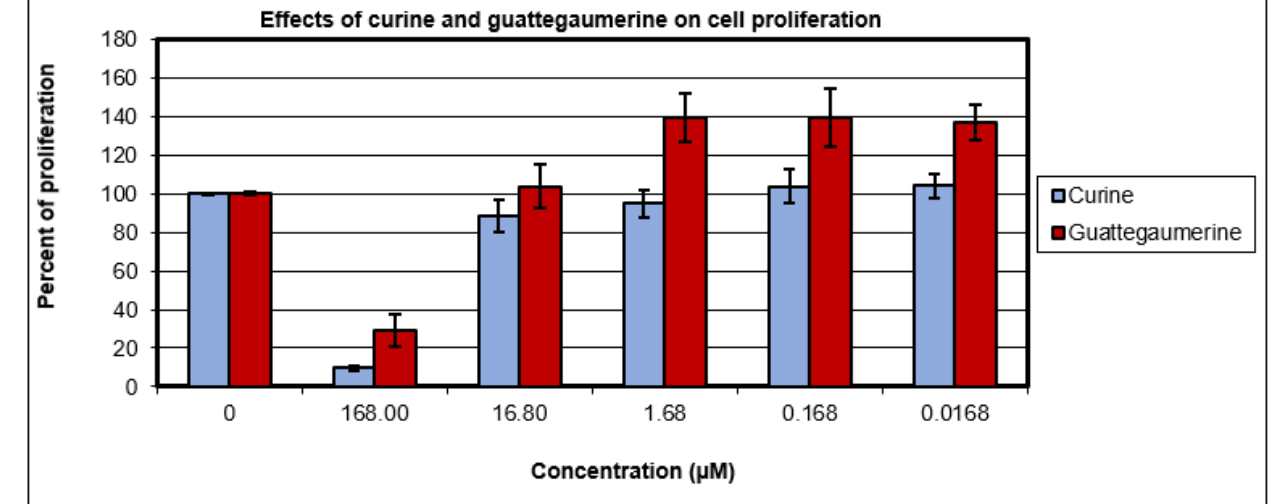
Figure 3. Effects of curine and guattegaumerine on the proliferation of HTC-R cells. The cells were grown in 24-well plates in the absence (control) or presence of concentrations of the curine and guattegaumerine indicated in abscissas. After 36 h of incubation, the percentage of living cells was calculated. Experiments were carried out three times in triplicate. Values represent the mean percentage of living cells ± standard deviation.